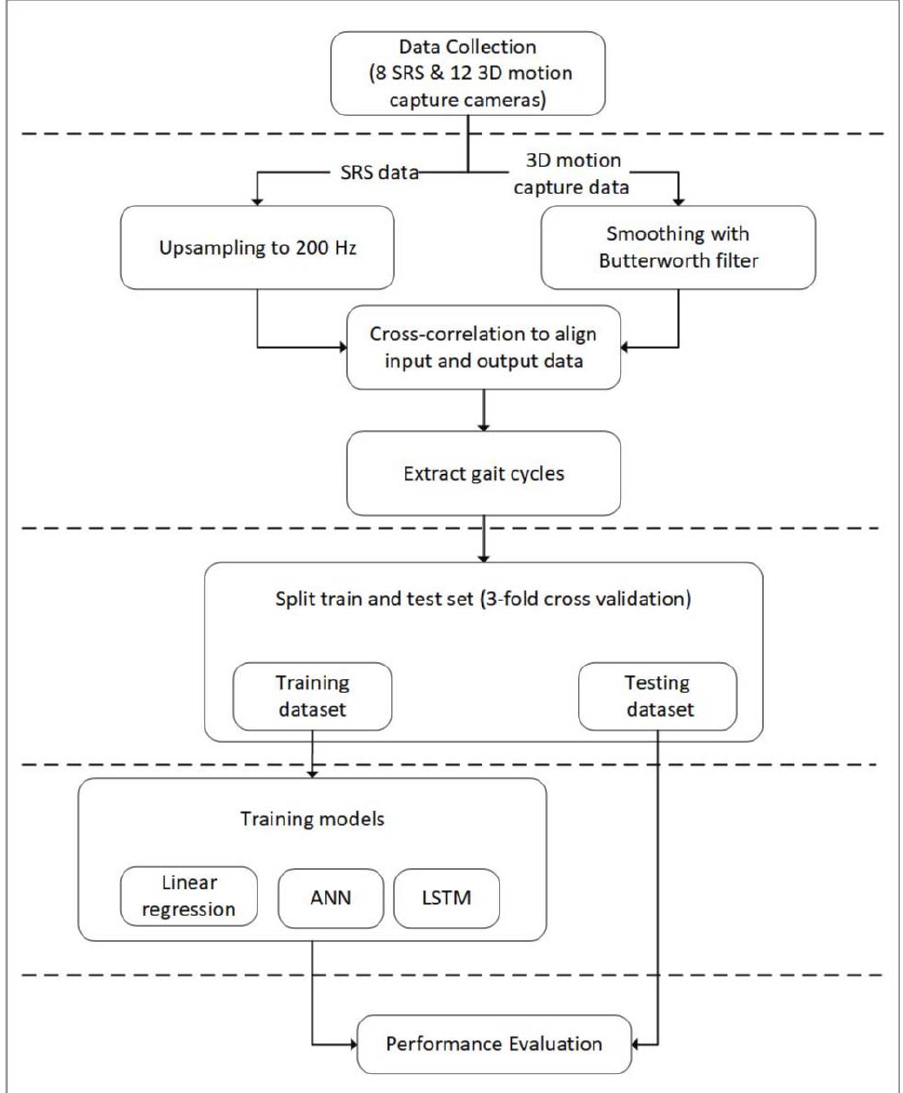
Figure 5. Process flowchart.